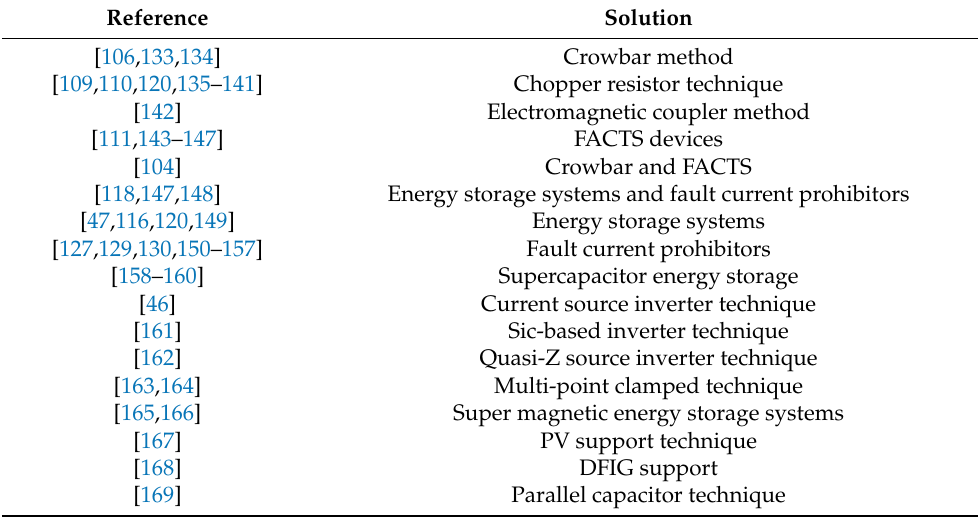
Figure 19. PMSG-based WECS LVRT capabilities using MSBFCL. Table 2. Hardware-based PMSG LVRT solution schemes.